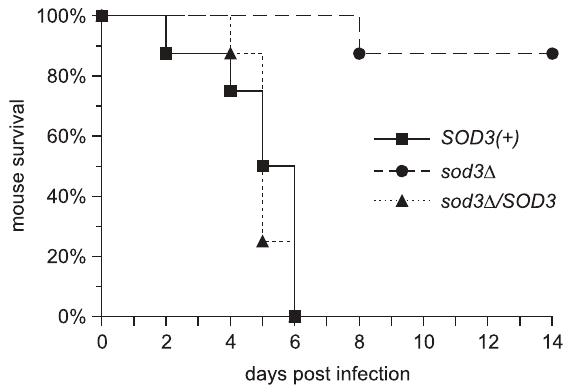
Figure 8. Lethal infection by Histoplasma requires Sod3 function. Kinetics of mouse survival after infection with a lethal dose of Histoplasma yeasts. Wild-type C57BL/6 mice were intranasally infected with 7 6 10 6 SOD3( + ) (OSU45), sod3 D (OSU15), or sod D /SOD3 (OSU49) Histoplasma yeasts (n=8 per strain). Survival time of mice infected with sod3 D yeasts differs significantly from that of infections with SOD3( + ) and sod D /SOD3 (p , 0.0001).